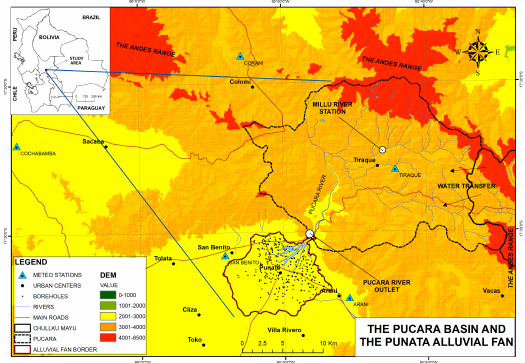
Figure 1. Pucara watershed system. Meteorological stations with similar climate conditions are also shown, such as San Benito, Tiraque, Cochabamba and